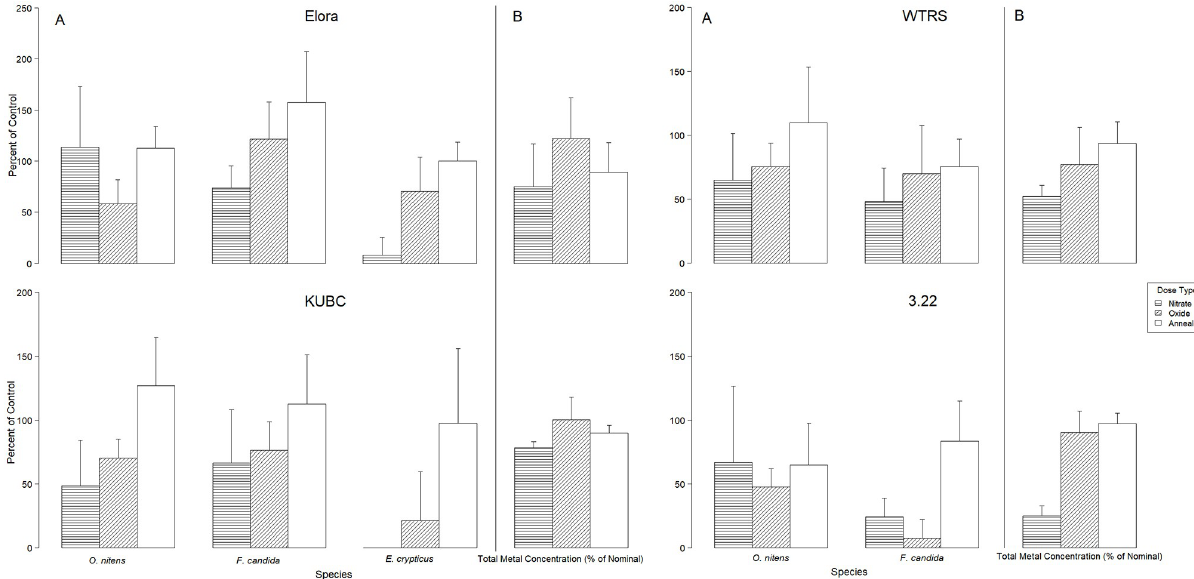
Fig 3. Effect of dosing method on invertebrate reproduction by soil. Average reproduction (as percent of control) for the three species pooled over all metal mixtures for each dosing method and soil (Panel A); total metal concentration as a percentage of nominal dose for each dosing method over all soils and mixtures (Panel B), Error bars represent the standard deviation of the mean ( O . nitens N = 20, E . crypticus n = 25, F . candida n = 25 Total metals n = 5).